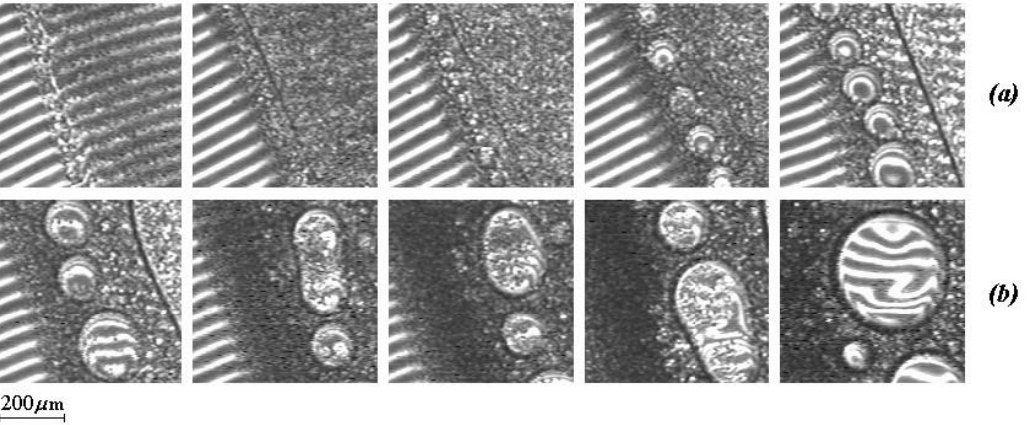
Figure 7. ( a ) Phase structure for decomposition zone II upon reaching 32 °C and after 109, 216, 344, and 564 sec, and ( b ) phase structure for decomposition zone II when the temperature rises to 33 °C and after 81, 131, 288, and 806 sec.